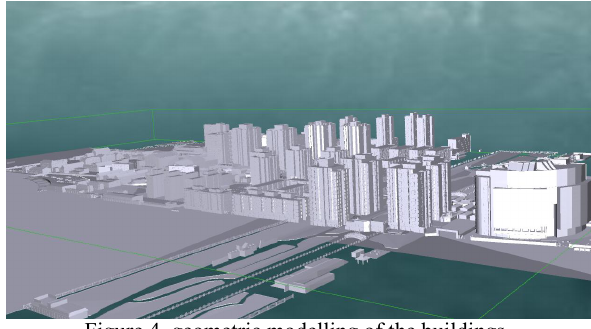
Figure 4. geometric modelling of the buildings.